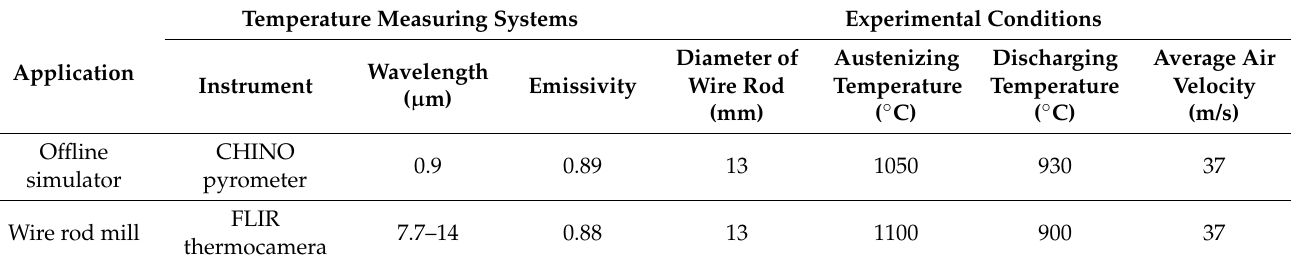
Table 3. Working conditions and thermometer specifications for temperature